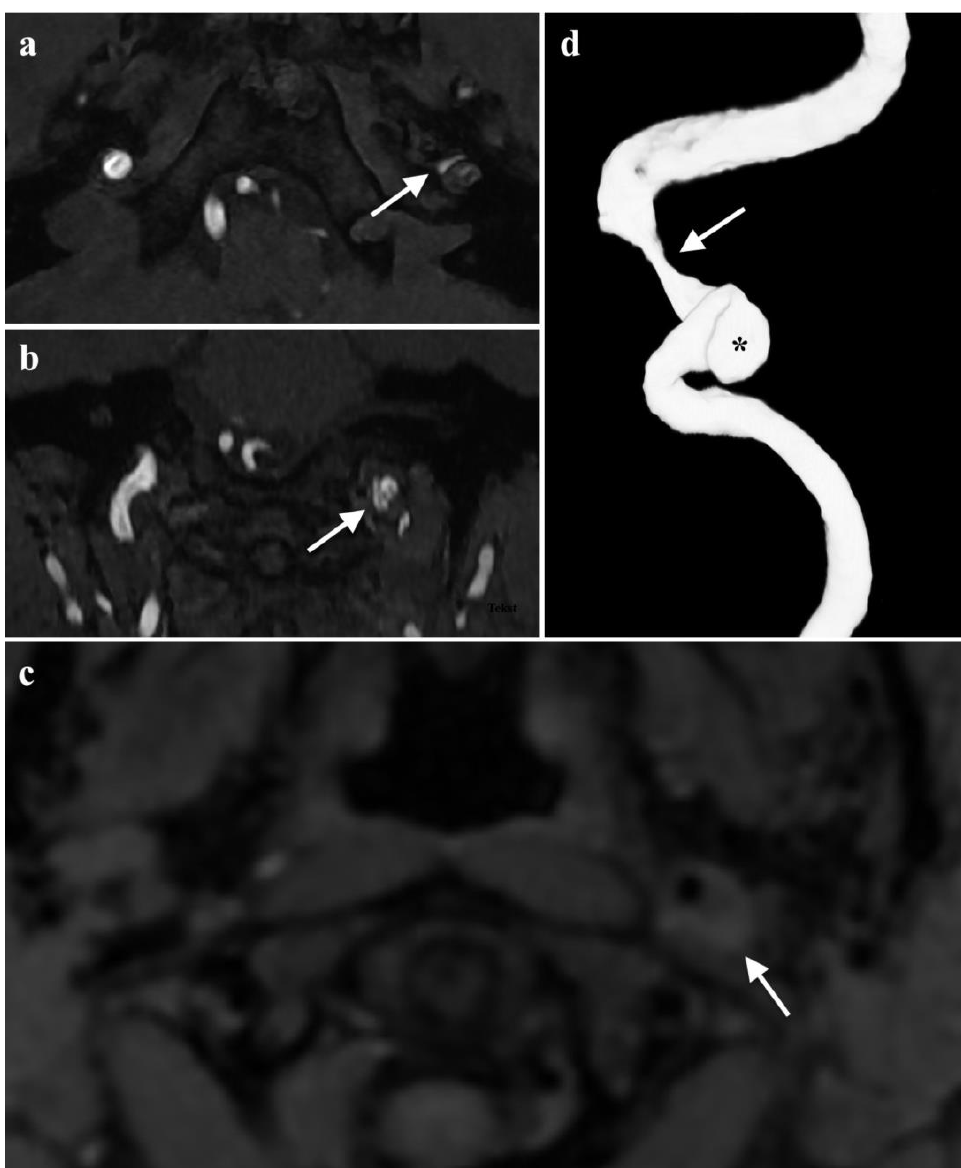
Figure 2. Baseline MRA of the head arteries: ( a ) TOF MRA image at the level of the carotid canal entrance showing the narrowing of the lumen of the left ICA (arrow); ( b ) TOF MRA image showing the false aneurysm of the left ICA (arrow); ( c ) prominent hyperintense crescent sign on the fat-saturated T1-weighted image caused by an eccentric intramural thrombus. The features are consistent with the diagnosis of left ICA dissection. ( d ) 3D VRT reconstruction demonstrates both the stenosis (arrow) and the false aneurysm (asterisk) of the left ICA.